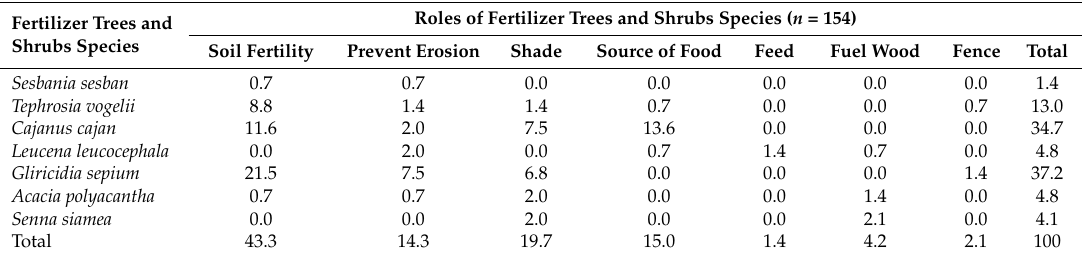
Table 2. Percentages of the perception of farmers on fertilizer trees and shrubs and their use. Fertilizer Trees and Shrubs Species